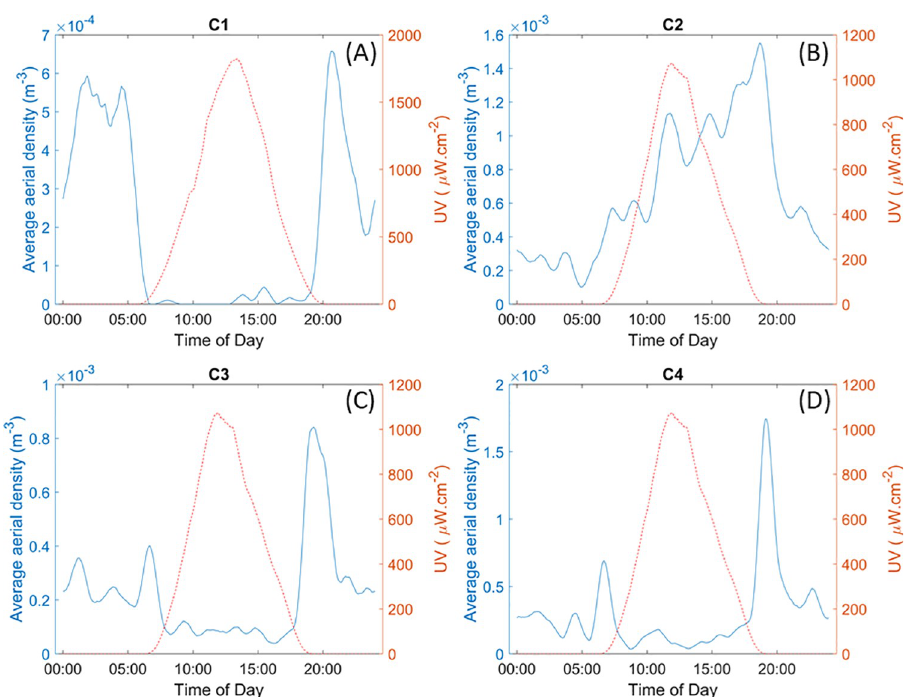
Fig 6. Typical circadian rhythm for cluster C1, C2, C3 and C4 (respectively A, B, C and D). The dotted line displays the UV radiation measured on the field which relates to the sun activity. The aerial density is the one hour sliding average over 14 consecutive days of